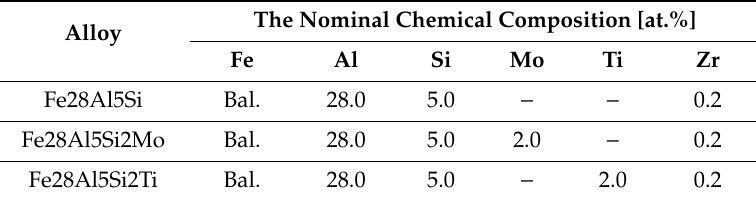
Table 1. The nominal chemical composition of investigated alloys. The Nominal Chemical Composition [at.%] Alloy Fe Al Si Mo Ti Zr Fe28Al5Si Bal. 28.0 5.0 − − 0.2 Fe28Al5Si2Mo Bal. 28.0 5.0 2.0 − 0.2 Fe28Al5Si2Ti Bal. 28.0 5.0 − 2.0